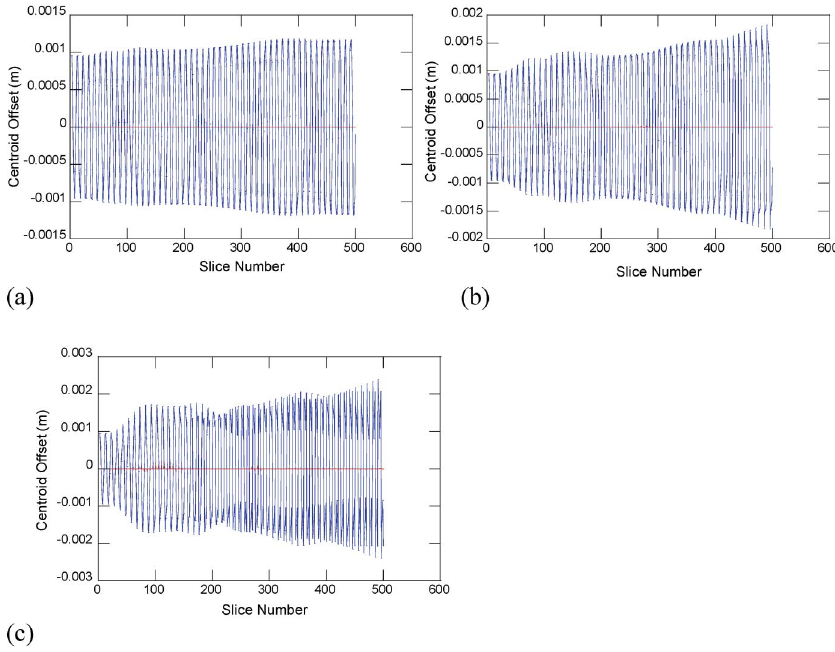
FIG. 21. (Color) Electron-beam centroid evolution for 20-MeV, 3-cm beam case at different axial positions. Each slice is 4 nsec long. The red line is for the horizontal offset and the blue line is for the vertical offset. (a) z (cid:4) 1 : 25 m , (b) z (cid:4) 2 : 5 m , and (c) z (cid:4) 5 m